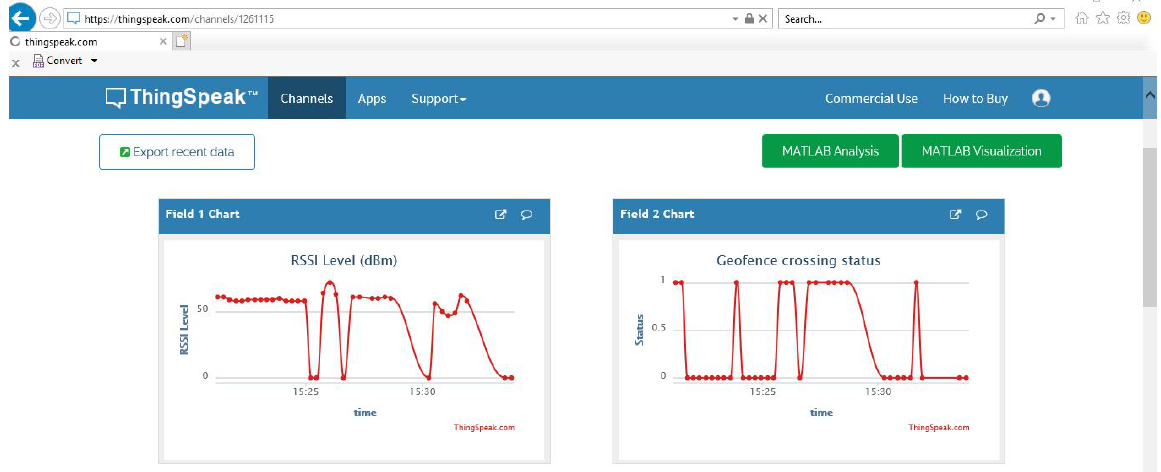
Figure 14. Sensors’ data visualization on the ThingSpeak Cloud.